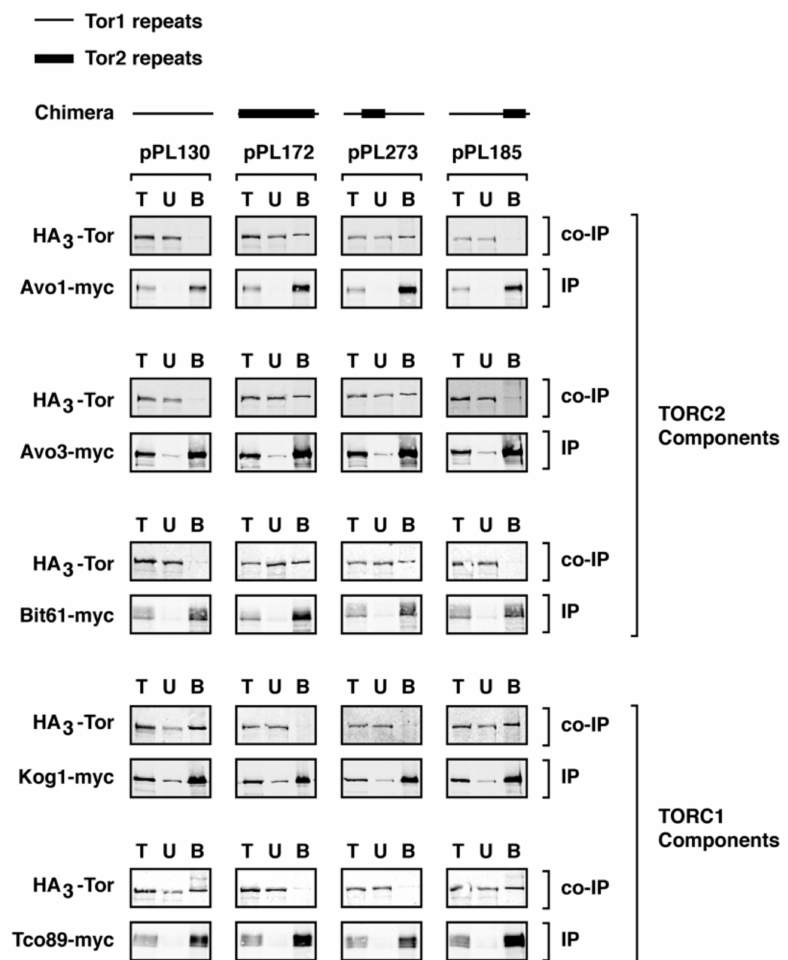
Figure 4. Assembly of chimeras into specific TOR Complexes. Indicated chimeras were assayed for assembly into TORC1 and TORC2 by examining co-immunoprecipitation between specific myc-tagged components (IP) and HA3-tagged chimeric Tor proteins (Co-IP). T = total material prior to IP; U = unbound material; B = bound material that indicates association between